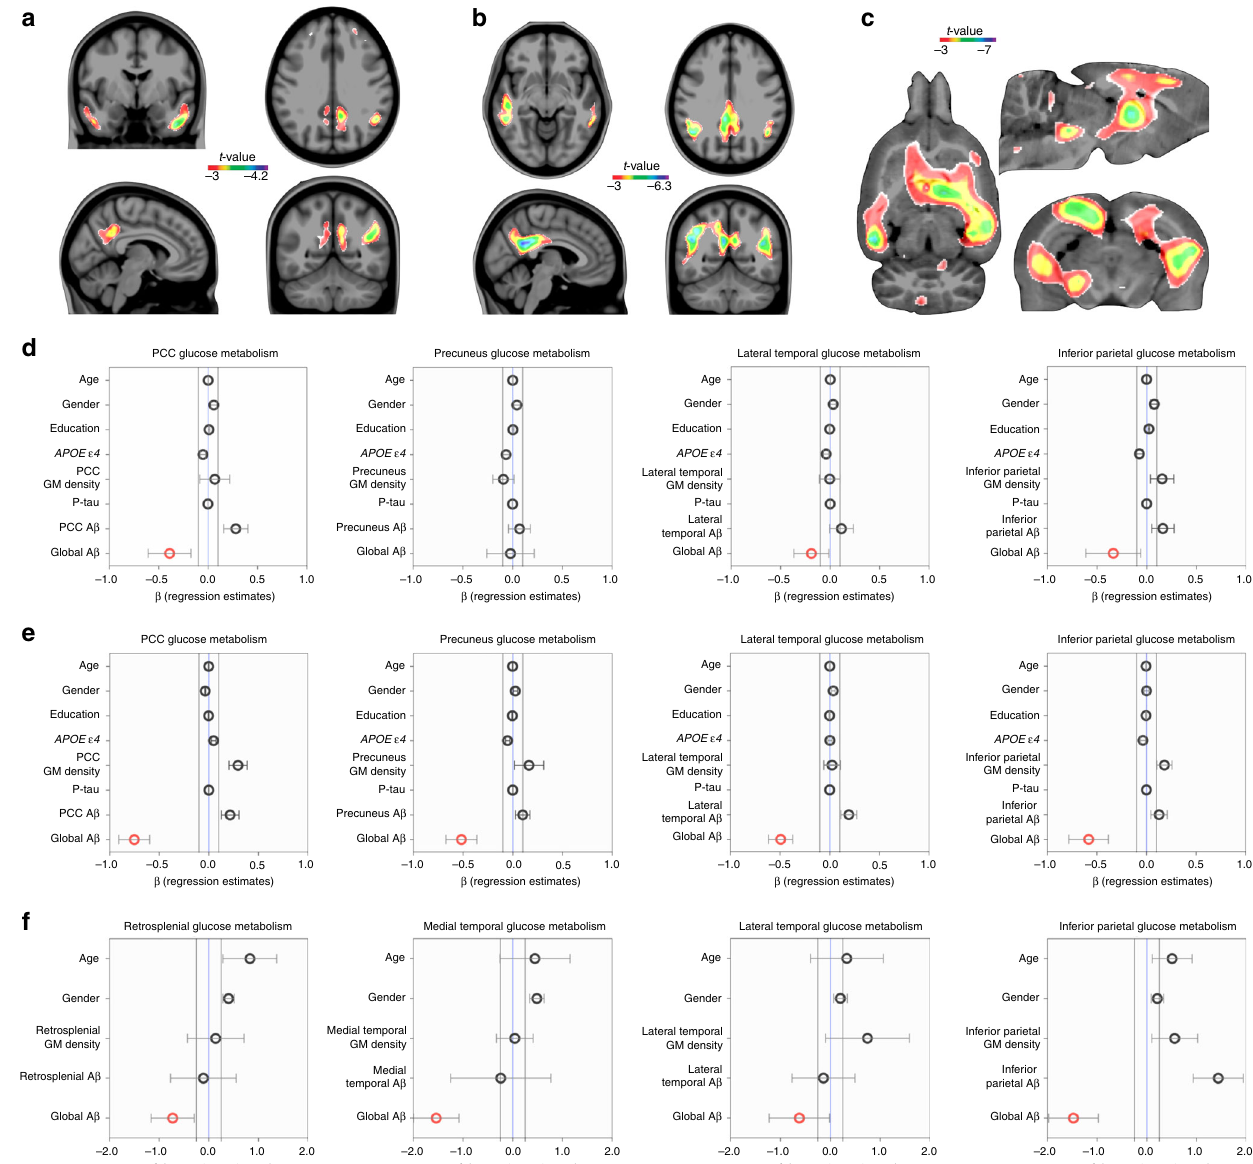
Fig. 1 Global rather than local amyloid- β (A β ) is associated with DMN hypometabolism. Voxel-wise models, taking voxel and global A β values into consideration, showed that global A β is associated with hypometabolism in ( a ) CN A β positive ( n = 53) and in ( b ) MCI A β -positive ( n = 170) individuals in the posterior cingulate, precuneus, lateral temporal, and inferior parietal cortices, and in ( c ) transgenic A β rats ( n = 10) in the retrosplenial (which corresponds to the posterior cingulate in humans), medial and lateral temporal, and inferior parietal cortices. The effects of regional A β values on its overlapping hypometabolism were negligible in the voxel-wise models. Regression models performed in ( d ) CN A β -positive and in ( e ) MCI A β -positive individuals within anatomically segregated regions further supported that the effects of local A β on hypometabolism (i.e., in the same region) were negligible. Similarly, inside segregated clusters, local A β effects on hypometabolism were negligible in ( f ) transgenic A β rats. In panels d – f , the dots and bars represent β estimates and standard error, respectively, of the independent variables used in the models. Parametric images were FWER corrected at P < 0.05 and adjusted for age, gender, education, APOE ε 4 status, p-tau, and gray matter (GM) density in humans, and age, gender, and gray matter density in with metabolism in distant, but metabolically connected brain supported that regions' proximity did not drive these regions in CN A β -positive (Fig. 2d) and MCI A β -positive correlations. (Fig. 2e – l; Supplementary Movie 1) individuals. Notably, the Voxel-wise network analysis showed that A β load in the elements of the A β -glucose and glucose – glucose matrices were precuneus, posterior cingulate, lateral temporal, inferior parietal, highly negatively correlated with one another in these individuals and medial prefrontal cortices were associated with distant, but ( r = − 0.5, P < 0.0001), which reinforced the link between within-DMN hypometabolism in CN A β -positive (Fig. 3) and metabolic connectivity and A β effect. Furthermore, the lack of MCI A β -positive (Fig. 4b – f) individuals. On the other hand, A β correlation between the A β -glucose matrix elements and the outside of the DMN either did not associate with hypometabo- Euclidean distance between regions ( r = 0.1, P = 0.3294) lism or was associated with hypometabolism predominantly in